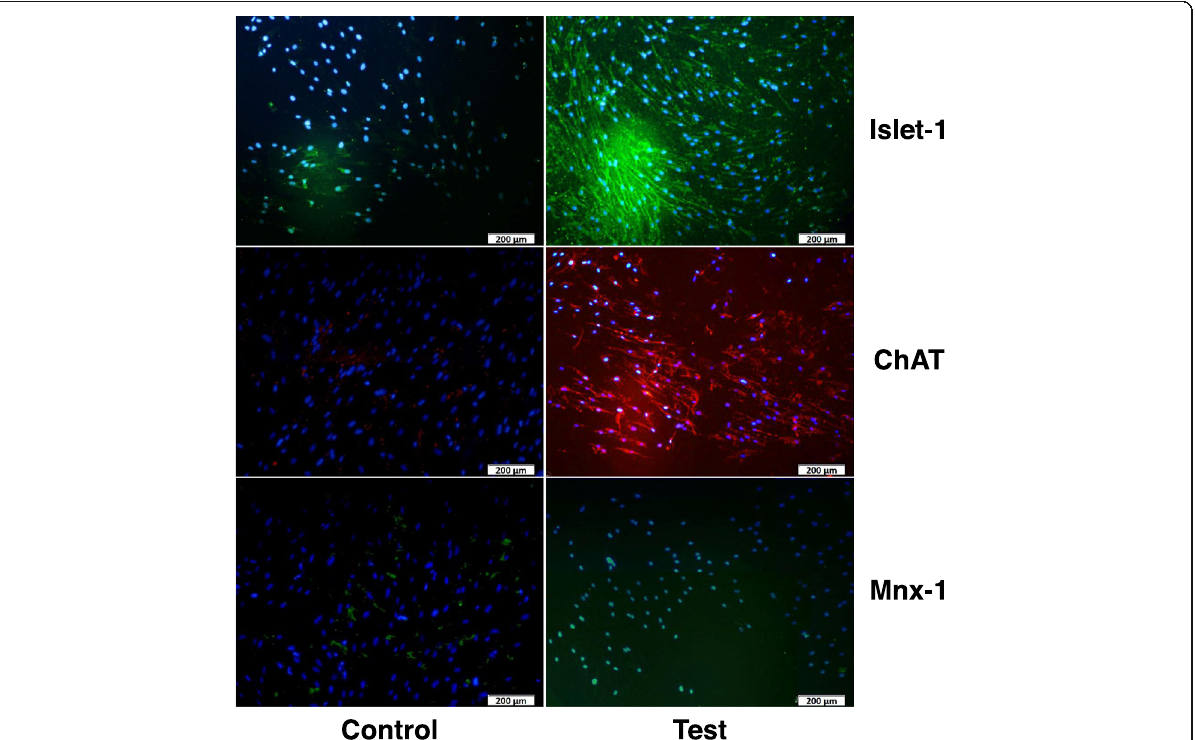
Fig. 2 Immunostaining of motor neuron-like cells derived from hBM-MSCs. The expression of Islet-1 (53 ± 10.1%), ChAT (45 ± 13.4%), and Mnx-1 antigens were investigated at the second week post-induction in the test group (treated hBM-MSCs) compared with the control group (non-treated